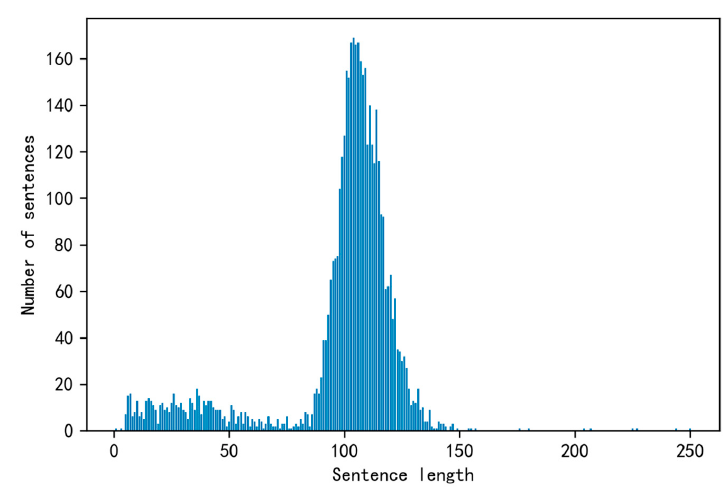
Figure 4. Length of the comment text of the Tower of London. Appl. Sci. 2020 , 10 , x